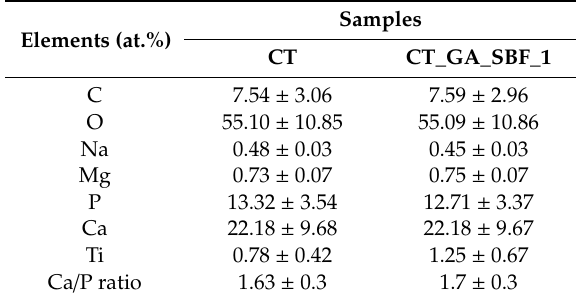
Table 4. Atomic percentages of the elements detected on the samples by EDS survey. Elements